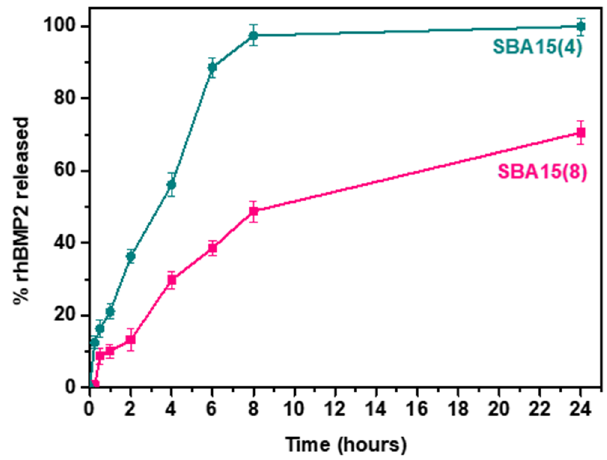
Figure 5. Amount (wt %) of released rhBMP ‐ 2 from SBA ‐ 15 MSNs at pH